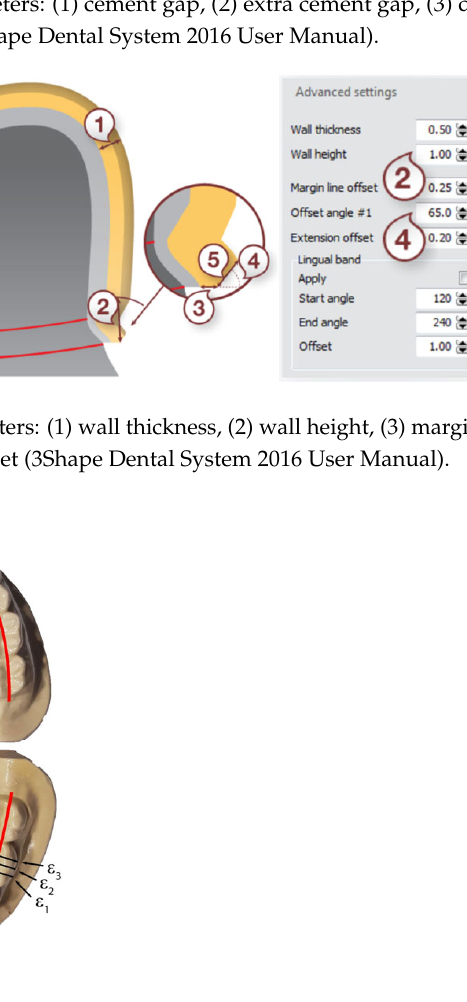
Figure 4. Design parameters: (1) cement gap, (2) extra cement gap, (3) distance to margin line, and